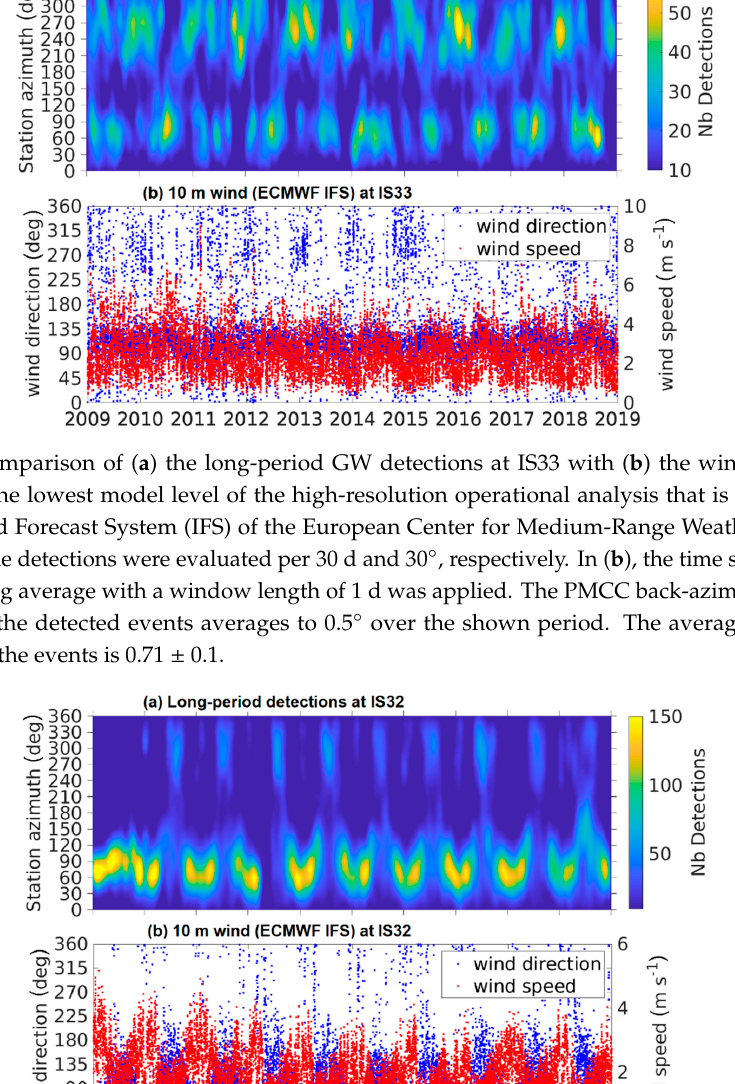
Figure 6. Comparison of ( a ) the long-period GW detections at IS33 with ( b ) the wind speed and direction at the lowest model level of the high-resolution operational analysis that is produced by the Integrated Forecast System (IFS) of the European Center for Medium-Range Weather Forecasts (ECMWF). The detections were evaluated per 30 d and 30°, respectively. In ( b ), the time series interval is 6 h; a sliding average with a window length of 1 d was applied. The PMCC back-azimuth standard deviation of the detected events averages to 0.5° over the shown period. The average correlation coefficient of the events is 0.71 ± 0.1.